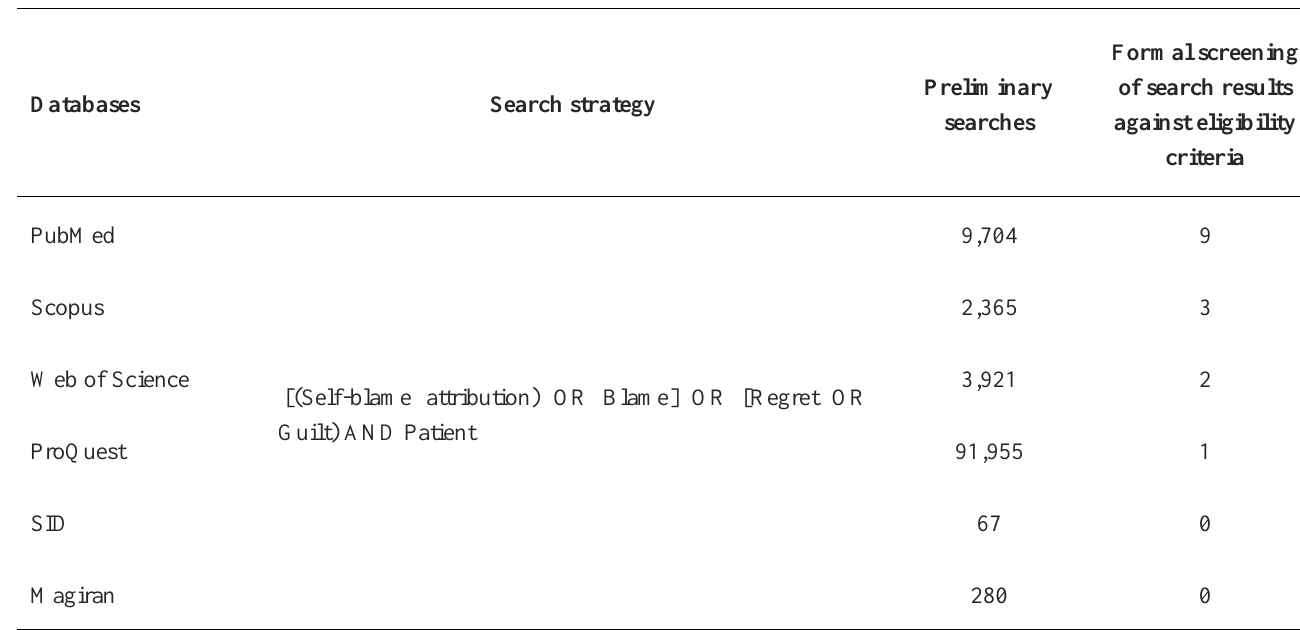
Table 1. Database search